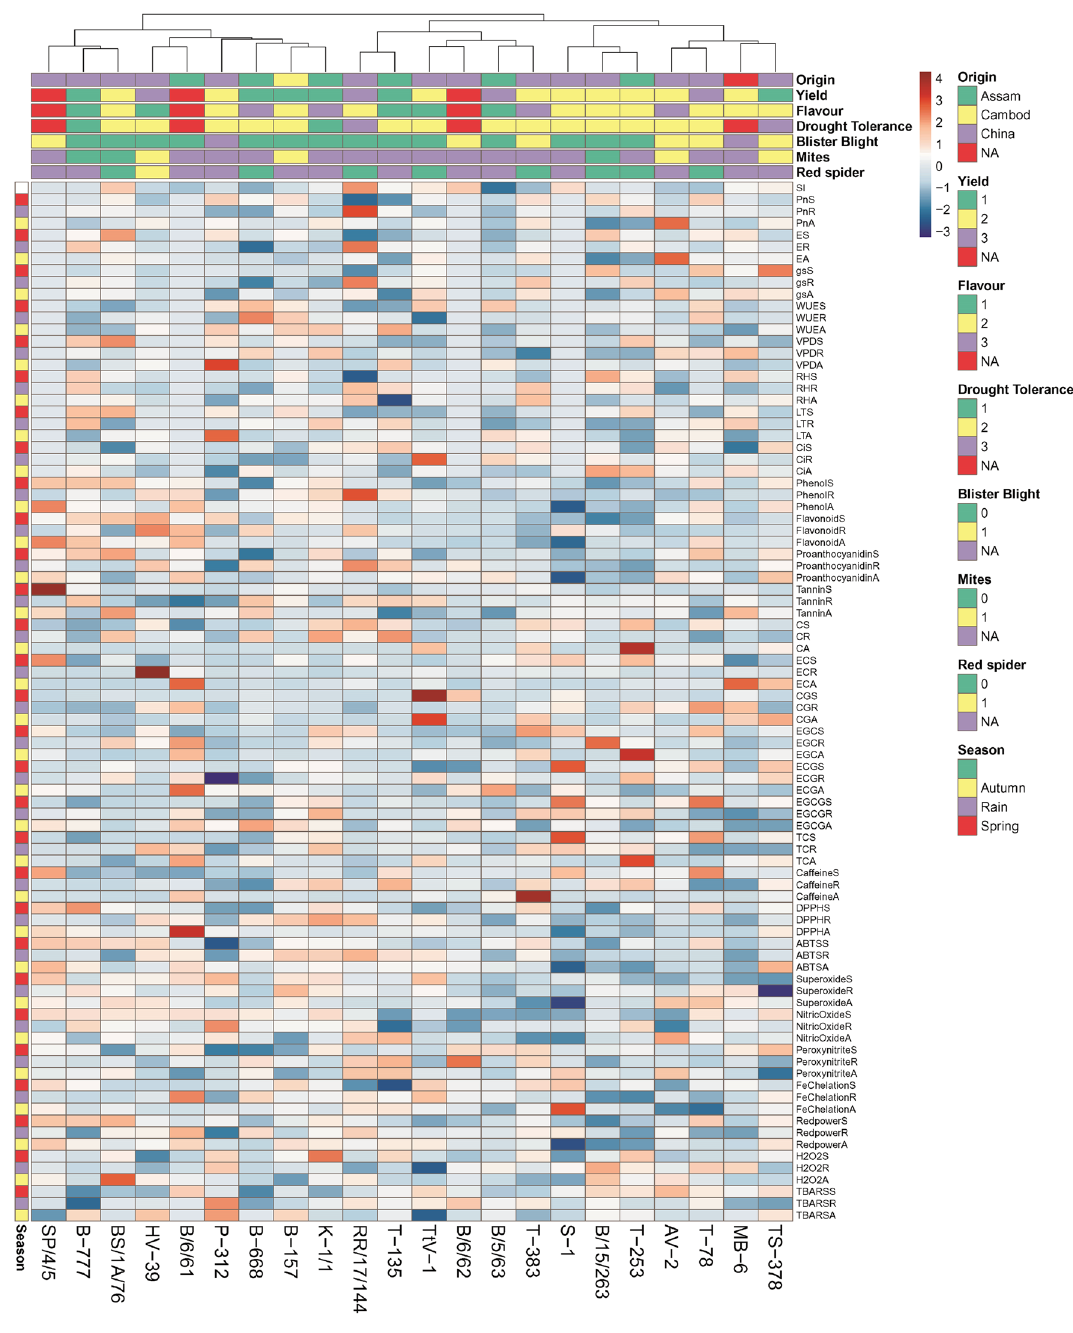
Figure 2. Hierarchical clustering showing incidences of the studied ecophysiological and biochemical variables (22 genotypes × 3 seasons). Rows are centered with unit variance scaling. Imputation is used for missing value estimation. Columns are clustered using correlation distance and Ward linkage. Agronomic characters of the genotypes 14 are denoted as—Yield: (1) < 1500 kg/ha, (2) 1500–2500 kg/ha, (3) 2500–3000 kg/ha; Flavour: (1) Average, (2) Good, (3) Excellent; drought tolerance: (1) Fair, (2) Good, (3) Very good; Blister blight, mites and red spider: (1) Resistant, (0) susceptible; NA data not available. Heatmap generation and hierarchical clustering have been carried out using ClustVis 18